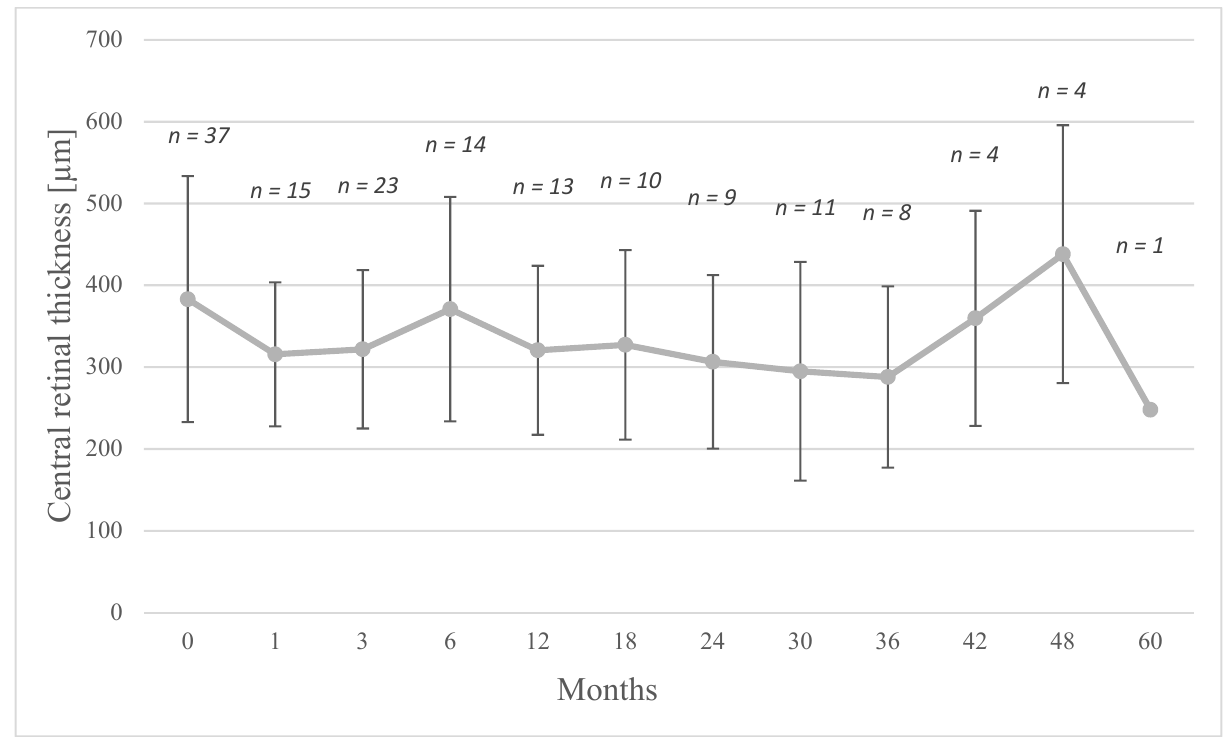
Figure 2. Central retinal thickness (mean ± SD) following the intravitreal injection of a FAc implant. At baseline, 37 eyes (including 3 reinjections) were included in the study; however, three failed to attend follow-up appointments after the baseline visit.